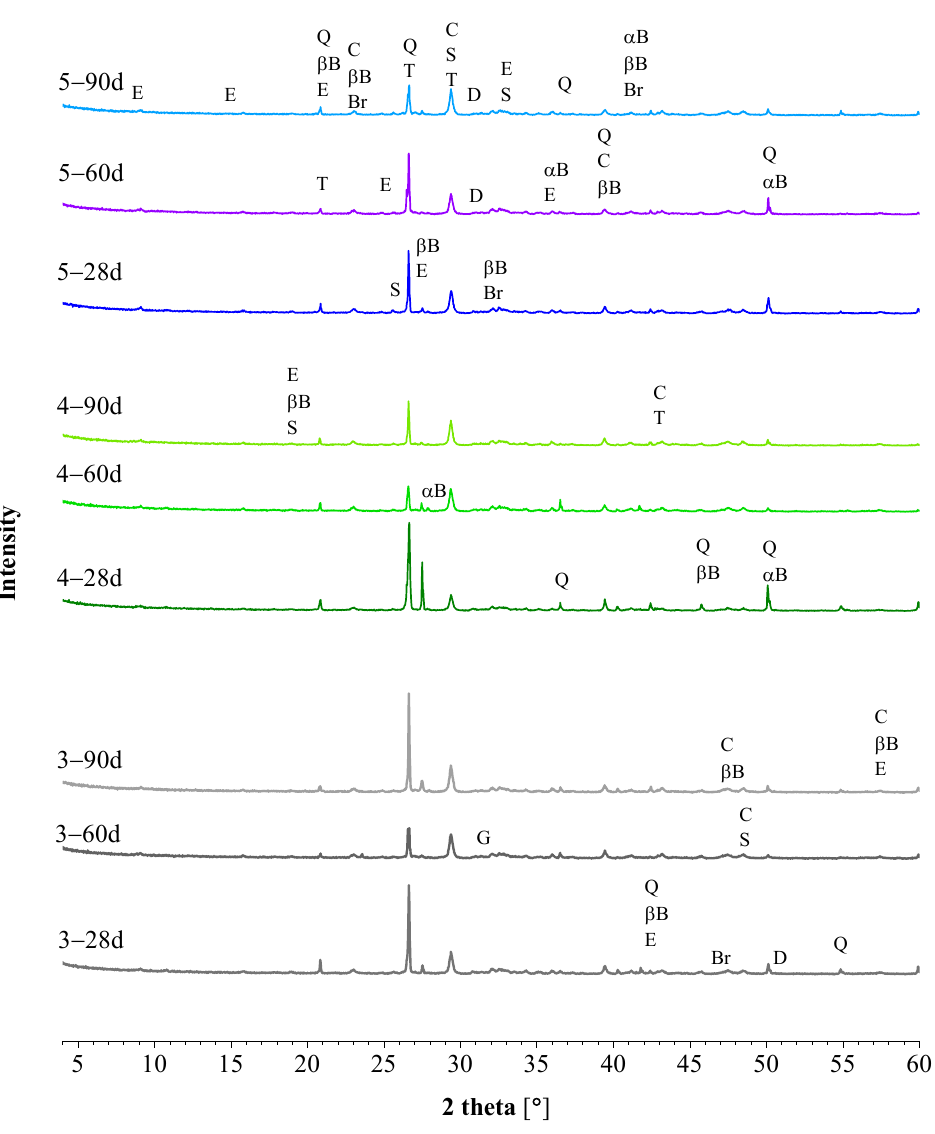
Figure 3. XRD analysis of NCPV mortars: 3_NCPV, 4_NCPV and 5_NCPV (b/a ratio 1:0.5, 1:1